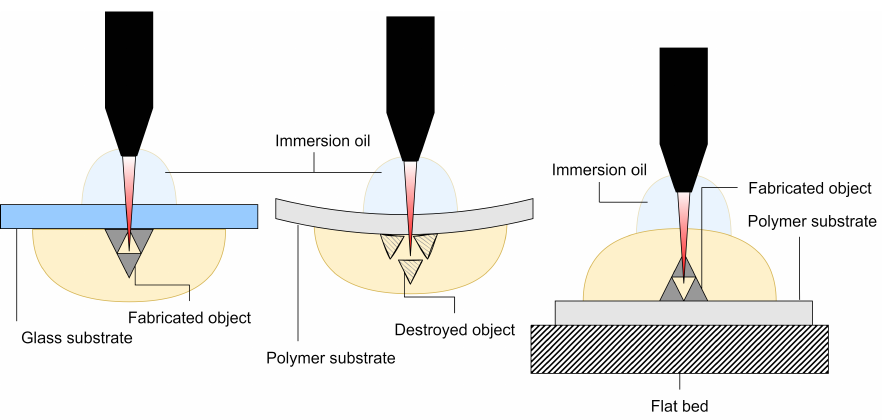
Figure 6. Different examined process possibilities to fabricate a structure via DLW, left to right: Through a glass substrate (standard route), through a thin polymer foil (tested, but no structures observed) and on top of polymer foil (applied route in this